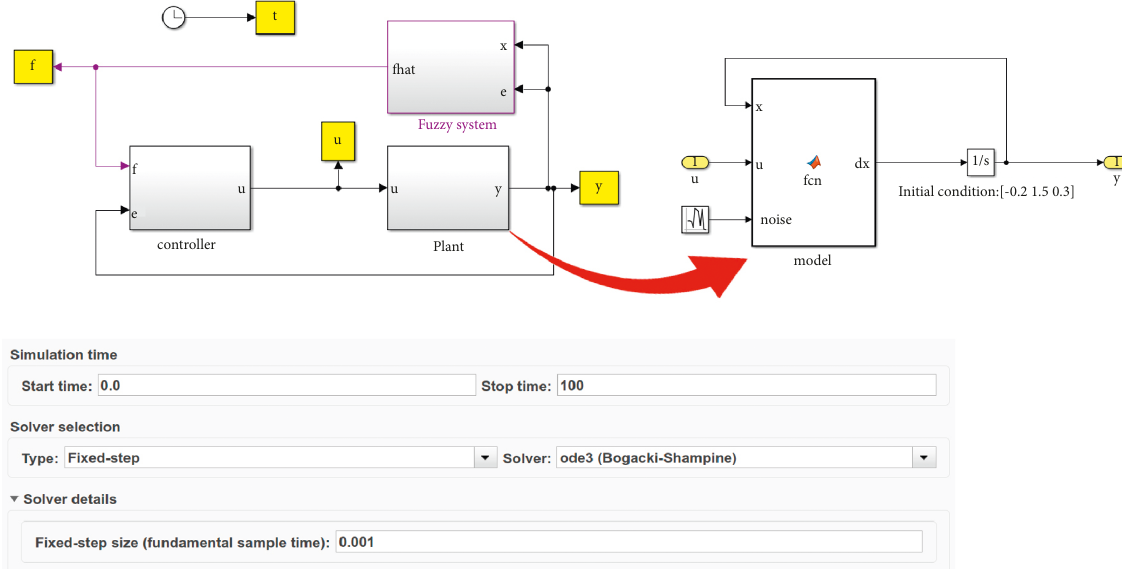
Figure 5: A general view of the simulation scheme.